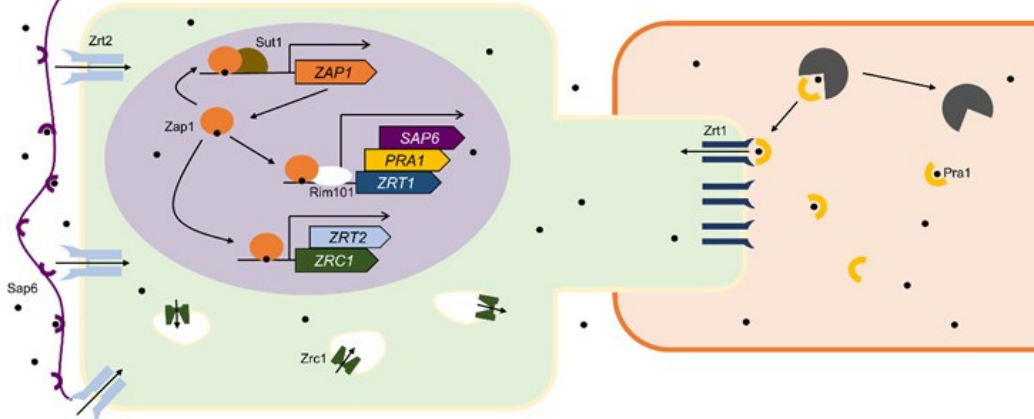
Figure 3. Mechanisms utilized in the maintenance of zinc homeostasis in Candida albicans under zinc deprivation. Zap1 is induced by Sut1 and induces ZRT2 (light blue) and ZRC1 (green), a plasma membrane zinc transporter and a zincosome zinc importer, respectively. Coupled with Rim101 (white), Zap1 also induces SAP6 , PRA1, and ZRT1 . Sap6 (purple) is a biofilm formation protein that also functions as a zinc “magnet”, facilitating metal internalization. Zrt1 (dark blue) is a zinc plasma membrane transporter that harvests zinc obtained by Pra1 (yellow), a secreted protein capable of detaching zinc bound to other proteins (represented in black) inside infected cells.